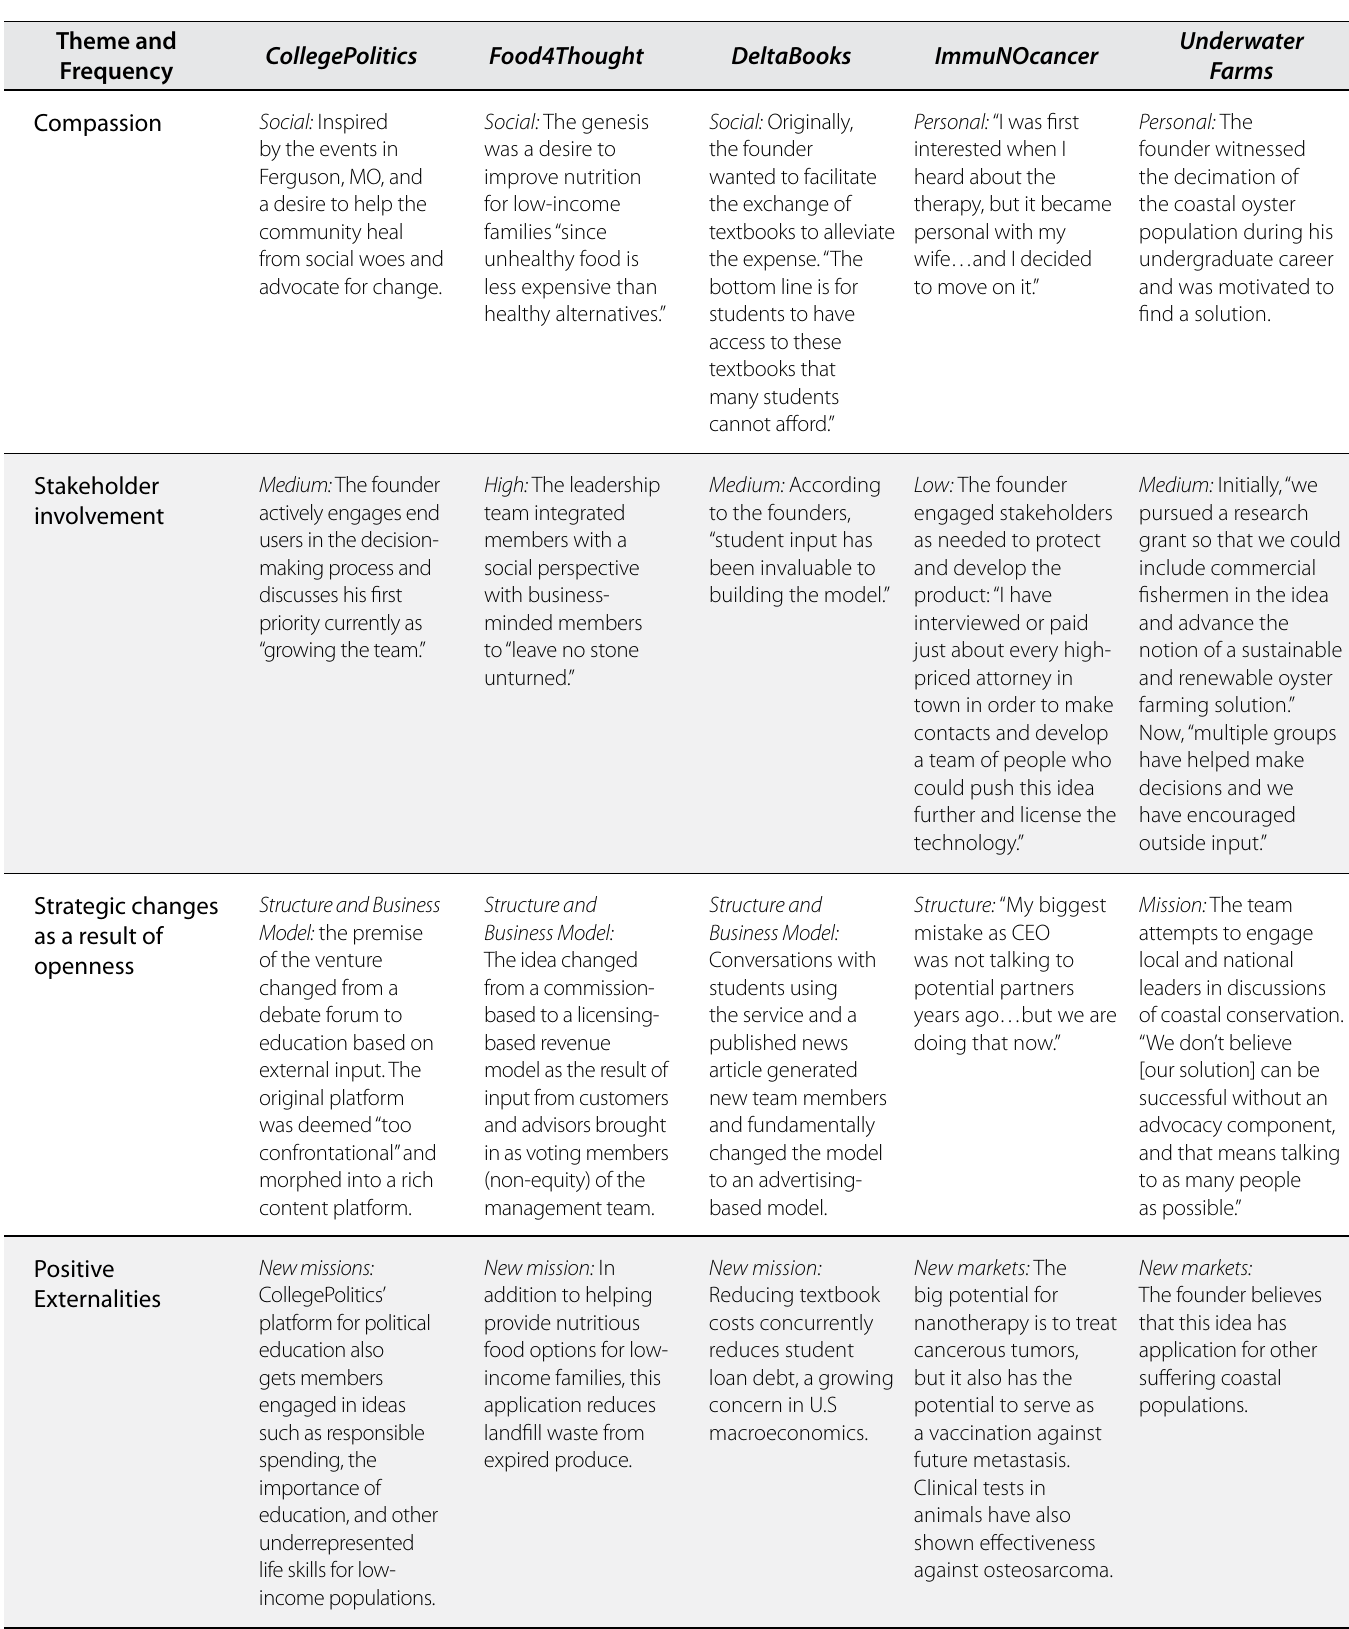
Table 1. Case Descriptions and Illustrative